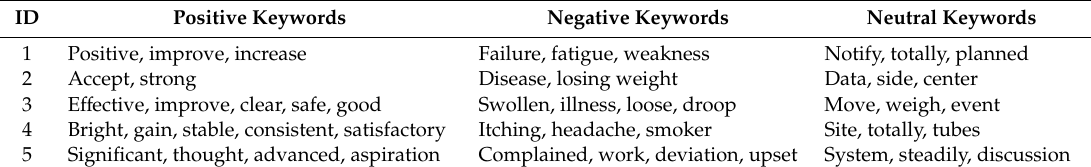
Table 3. The positive, negative and neutral keyword list for each discharge summaries.